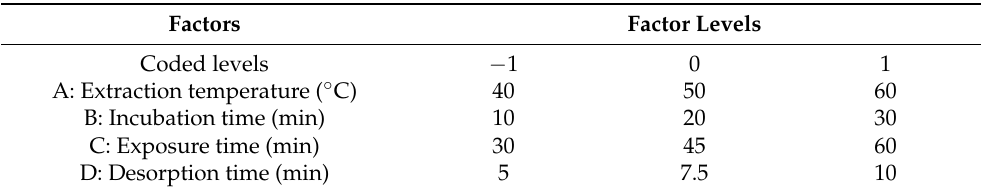
Table 5. Independent factors and their levels used in the BDD for optimization of SPME-Arrow extraction for determination of free volatile